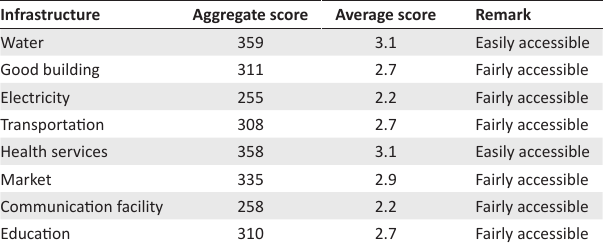
TABLE 6: Accessibility to infrastructure throughout the chain.